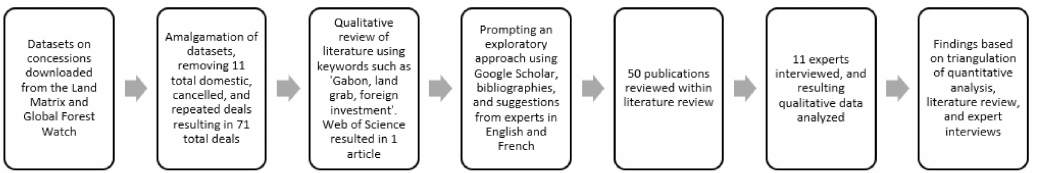
Figure 1. Process of the framework of